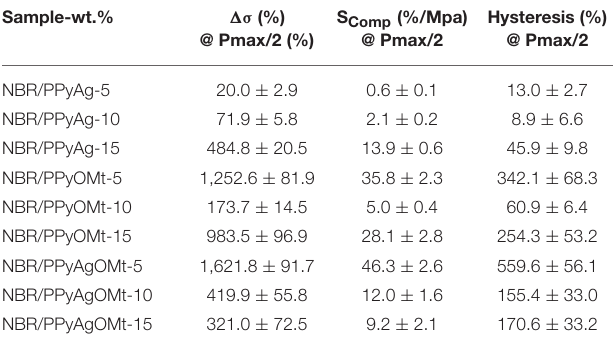
TABLE 2 | Electromechanical properties.